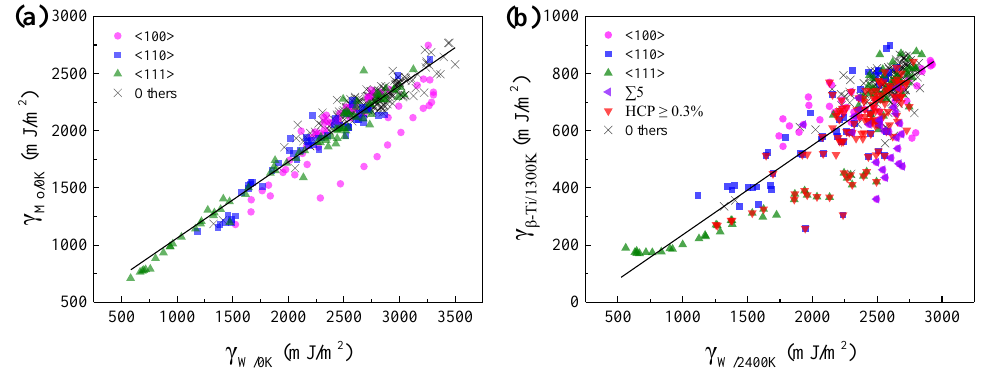
Figure 9. The relationships of GBEs ( a ) between Mo and W at 0 K, and ( b ) between β -Ti at 1300 K and W at 2400 K. Every point in Figure 9 corresponds to a GB. The magenta circles, blue squares, olive up triangles, and black crosses in ( a ) and ( b ) correspond to the GBs with the misorientation axes of <100>, <110>, <111> and others. The violet left triangles and red down triangles in ( b ) correspond to the ∑5 GBs and the GBs with the percentage of HCP atoms no less than 0.3% in β -Ti at 1300 K, respectively.